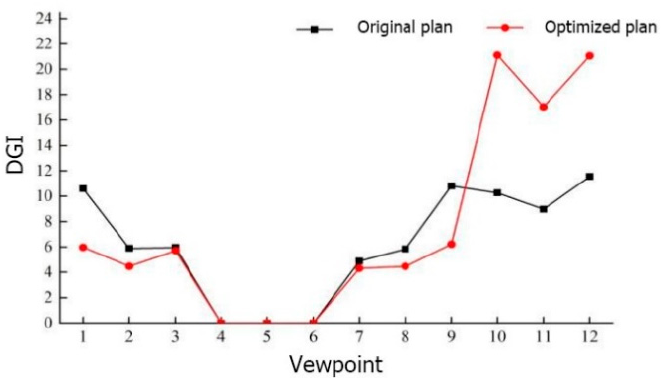
Figure 15. The DGI values of daylighting through high side windows before and after the optimization